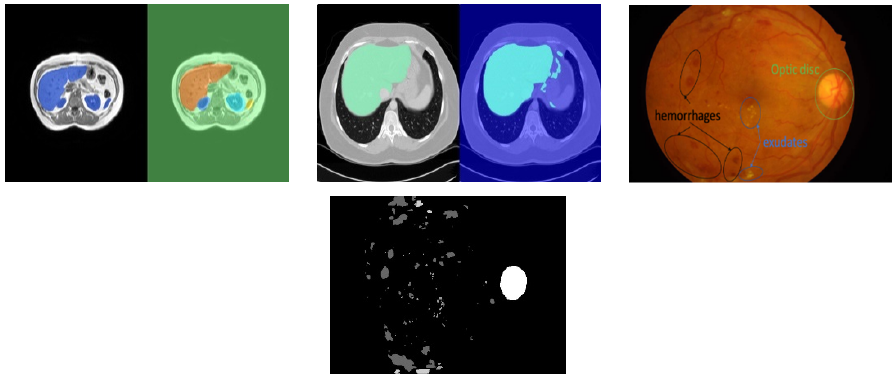
Figure 2. Illustrative examples from the three datasets used. Left: MRI segmentation of liver, spleen, left and right kidneys (groundtruth + segmented); Center: computer tomography (CT) segmentation of liver (groundtruth + segmented); Right: eye fundus image (EFI) with indication of some lesions and example groundtruth.